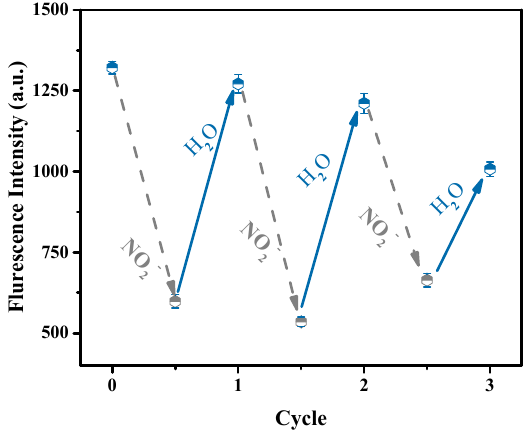
Figure 9. Fluorescence intensity of fluorescence sensor in three cycles.